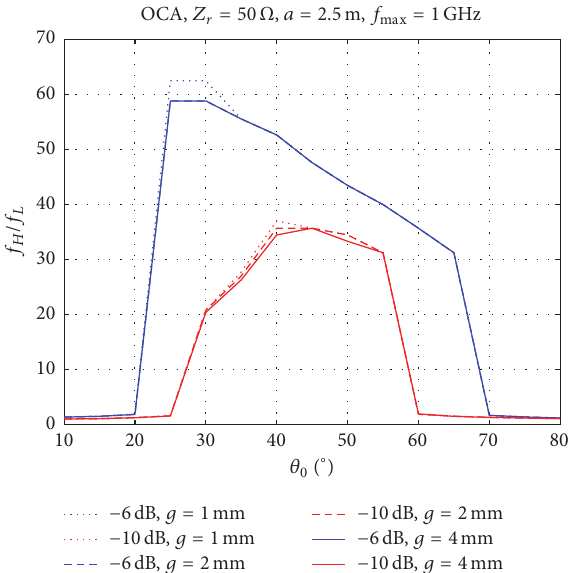
Figure 26: 𝑆 11 of the OCA for 3 different gap lengths, 𝜃 0 = 75 ∘ and Ω . 𝑍 𝑟 = 50